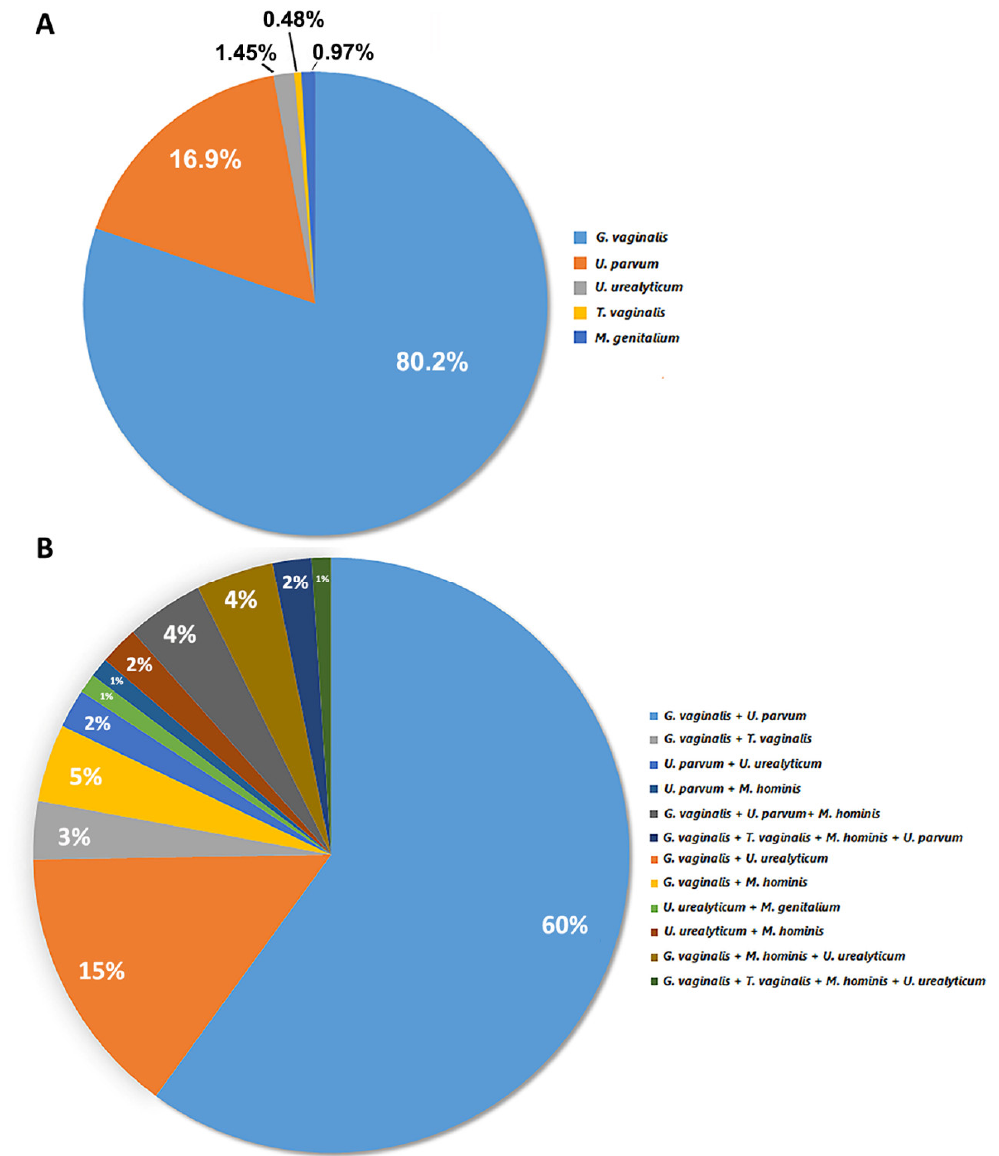
Figure 2. Distribution of single infection ( A ) and multiple infection ( B ) rates of genital microorganism in whole-positive cohort. In our study, among the subjects found positive for single infections (207/717) (Supplementary Materials Table S1), G. vaginalis and U. parvum represented the most common findings with a prevalence of 80.2% (166/207) and 16.9% (35/207), respectively (Figure 2A). Other identified microbial species included U. urealyticum (3/207; 1.45%), M. genitalium (2/207; 0.97%), and T. vaginalis (1/207; 0.48%) (Figure 2A). About the distribution of multiple infections, the double infection caused by G. vaginalis and U. parvum (57/95; 60%) resulted the most prevalent multiple infection, fol- lowed by G. vaginalis and U. urealyticum (14/95, 15%) (Table 2; Figure 2B); the remaining double infections represented together the 14% (13/95) of analyzed samples (Table 2; Figure 2B). Triple and quadruple infections showed a prevalence of 8% (8/95) and 3% (3/95), respectively (Table 2; Figure 2B). Among multiple infections, G. vaginalis was pre- sent in all the reported combinations (Figure 2B).